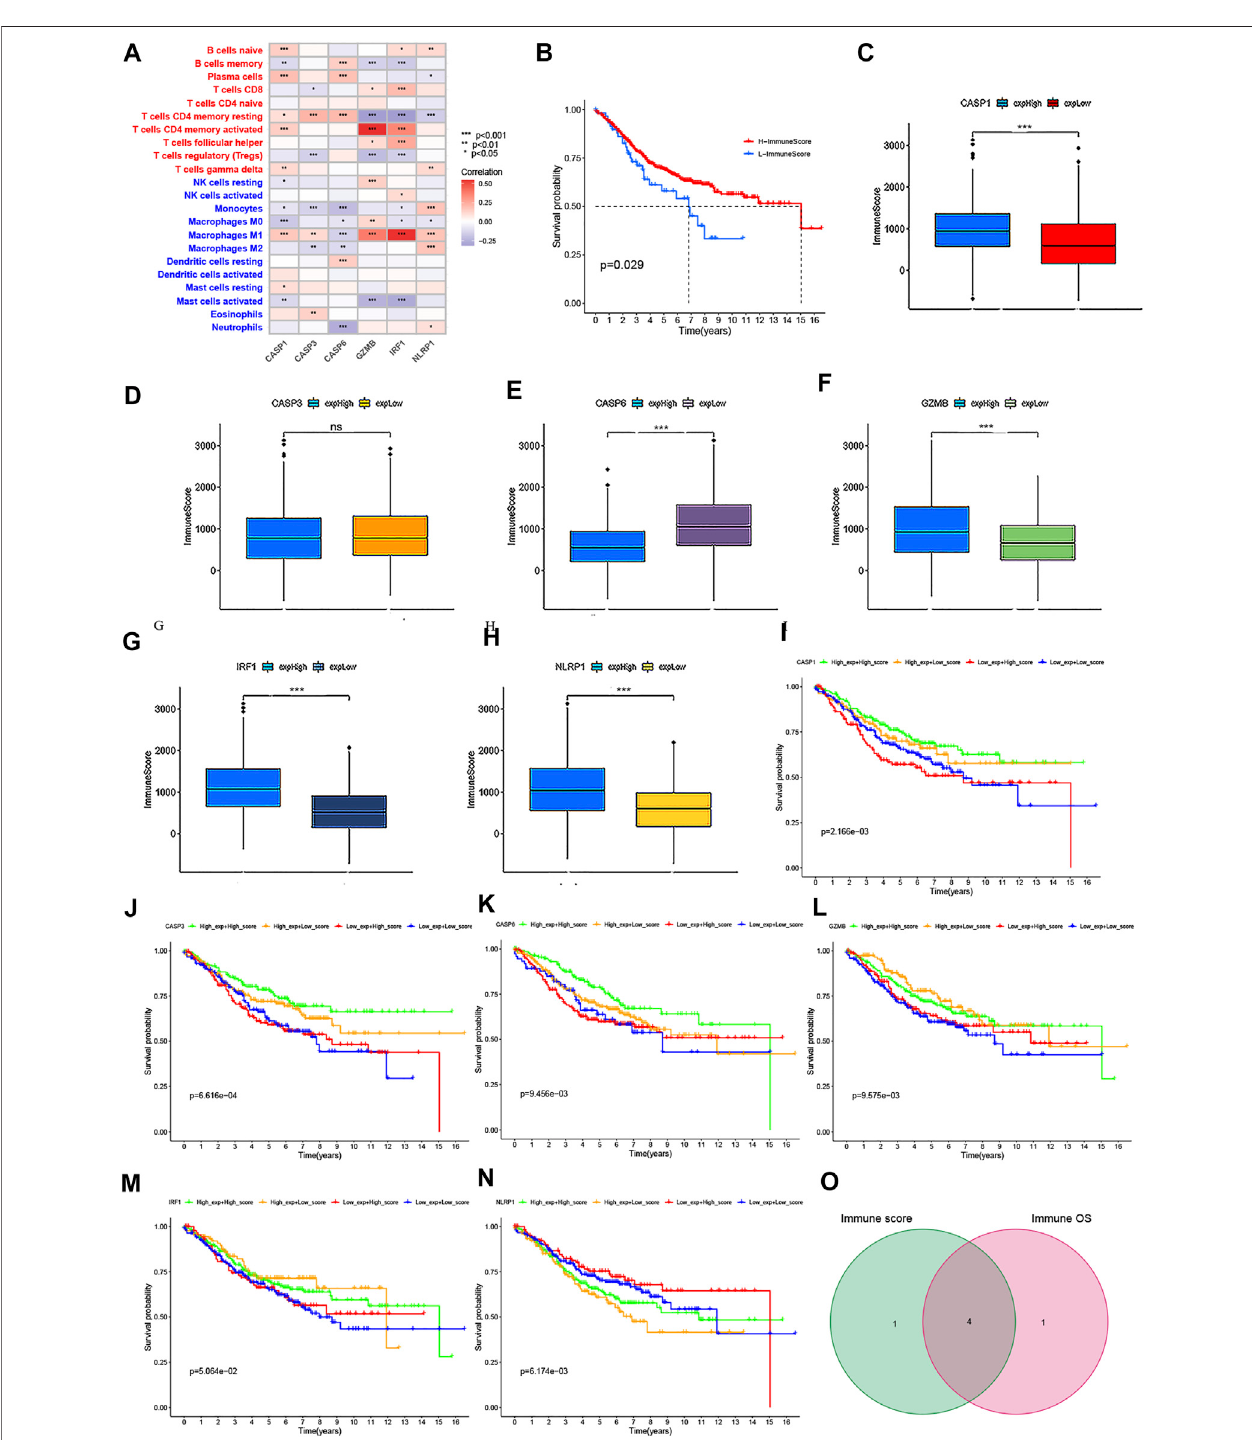
FIGURE 12 | Correlation of the immune score with the OS of patients in CRC. (A) Relationships between the abundance of 22 types of immune cells and six PRG signatures. (B) Kaplan – Meier curves for the high- and low-immune score with the cut-off value -11.072 of 579 CRC patients. (C – H) Relationships between the expression levels of six PRG signatures and immune score with the cut-off value -11.072 of 579 CRC patients. (I – N) Kaplan – Meier curves for CRC patients in immune score and PRG signature expression subgroups. (O) Venn plot showed four common PRG signatures based on both immune score and prognosis. p < 0.05 was the cut-off. * p < 0.05; ** p < 0.01; and *** p < 0.001.